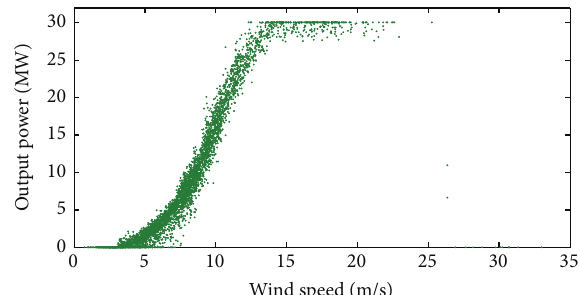
Figure 2: Power curve using actual data for a group of wind turbines at a wind farm (NREL)